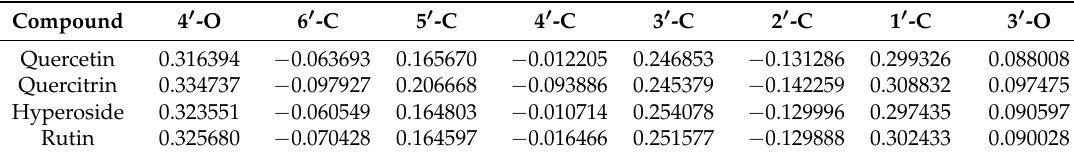
Table 6. The C-ring’s spin density of quercetin, quercitrin, hyperoside and